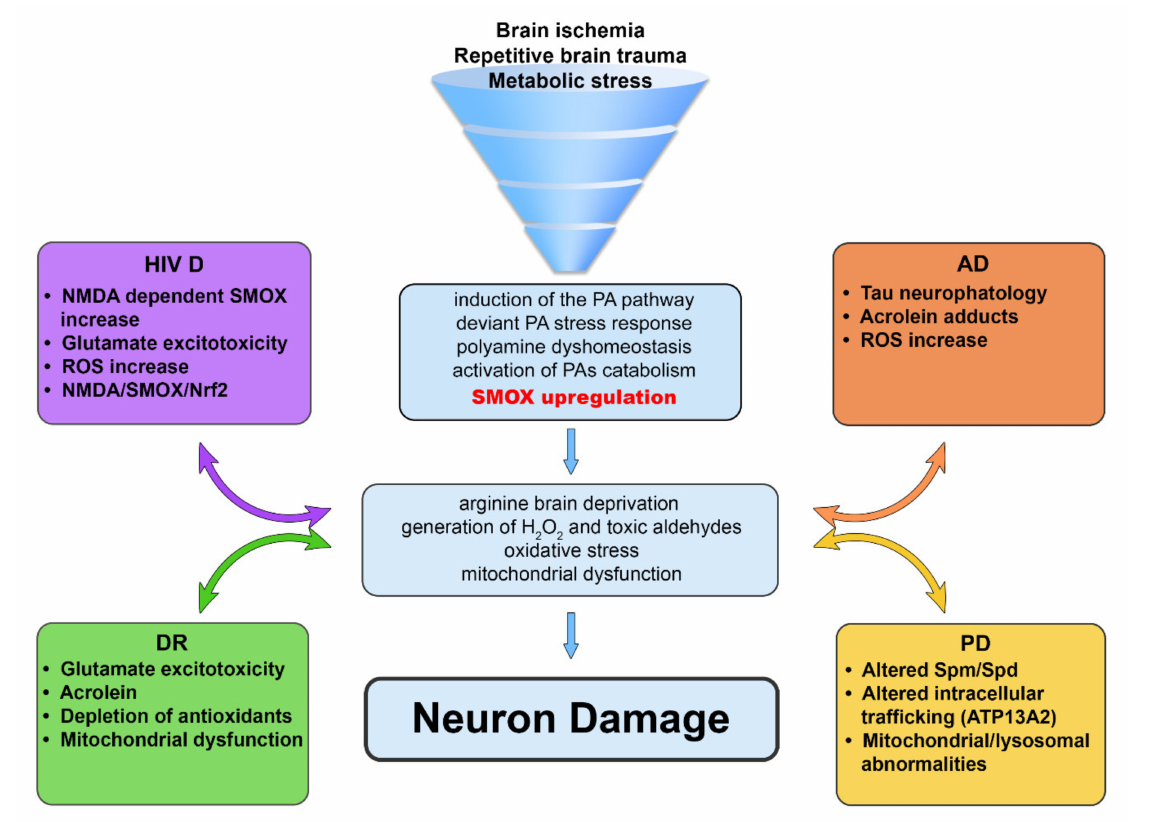
Figure 3. Schematic representation of the major mechanisms involved in neuronal damage result- ing from polyamine dyshomeostasis in the central nervous system. Polyamine dyshomeostasis- dependent mechanisms that have been suggested to play pivotal roles in representative relevant diseases are also highlighted. AD, Alzheimer’s disease; DR, diabetic retinopathy; HIV D, HIV- associated dementia; PD, Parkinson’s